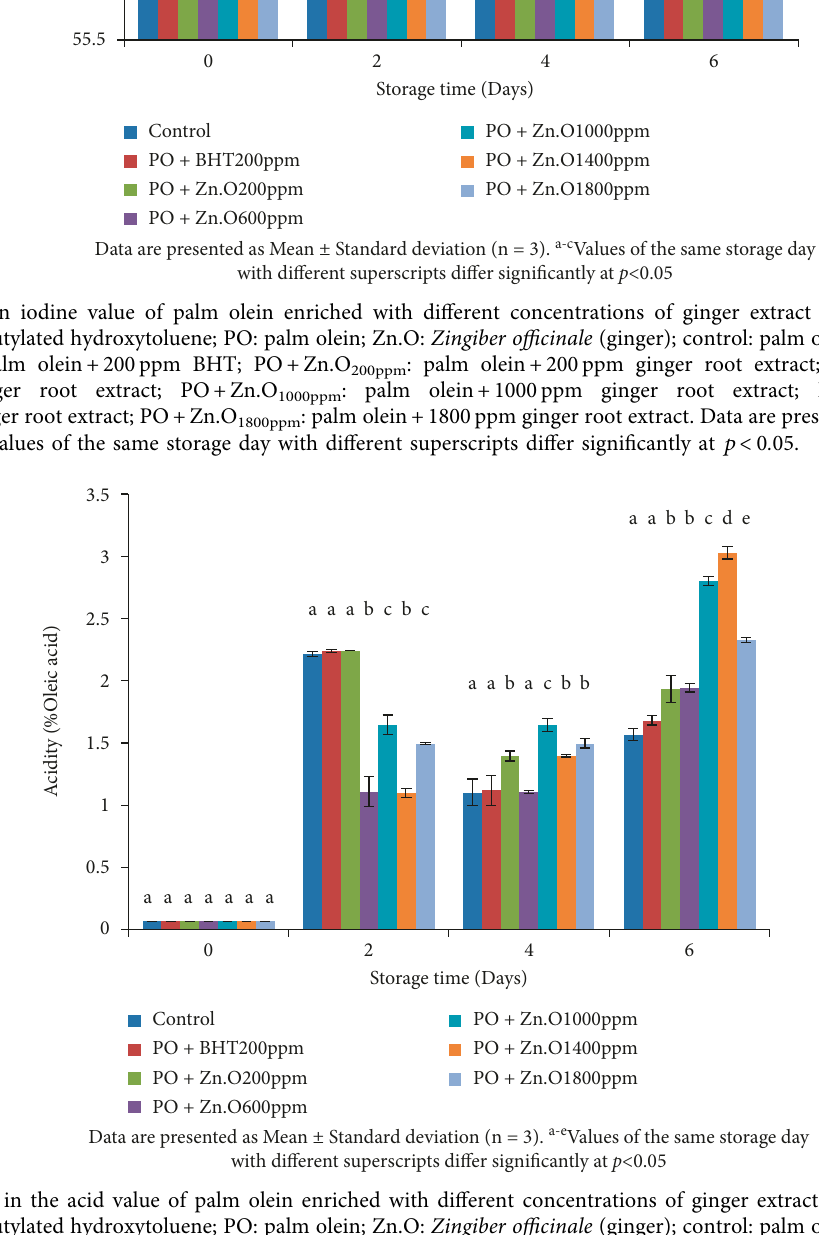
Figure 6: Variations in the acid value of palm olein enriched with different concentrations of ginger extract during storage at frying temperature. BHT: butylated hydroxytoluene; PO: palm olein; Zn.O: Zingiber officinale (ginger); control: palm olein without antioxidant; PO+BHT 200 ppm : palm olein+ 200ppm BHT; PO +Zn.O 200ppm : palm olein+200ppm ginger root extract; PO +Zn.O 600ppm : palm olein+600ppm ginger root extract; PO+Zn.O 1000ppm : palm olein+1000ppm ginger root extract; PO+Zn.O 1400ppm : palm olein+1400ppm ginger root extract; and PO +Zn.O 1800ppm : palm olein +1800ppm ginger root extract. Values with different superscripts on the same days are significantly different at p < 0 . 05. Data are presented as mean ± standard deviation ( n � 3). a–e values of the same storage day with different superscripts differ significantly at p < 0 .